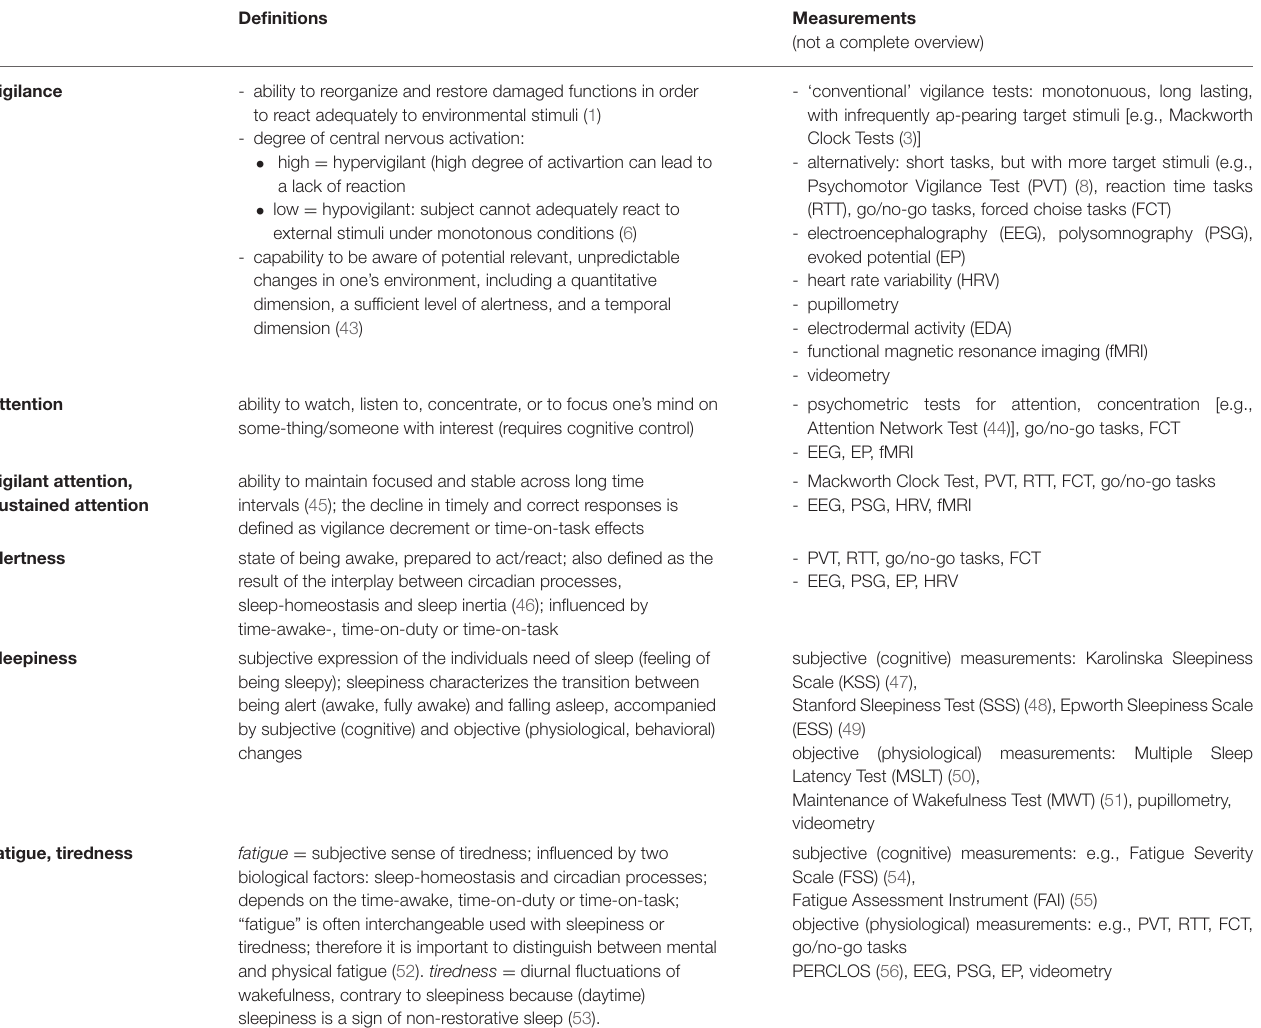
TABLE 1 | Overview of the different definitions of vigilance, attention (vigilant, sustained), alertness, sleepiness, fatigue, tiredness and related tasks paradigms (measurements).